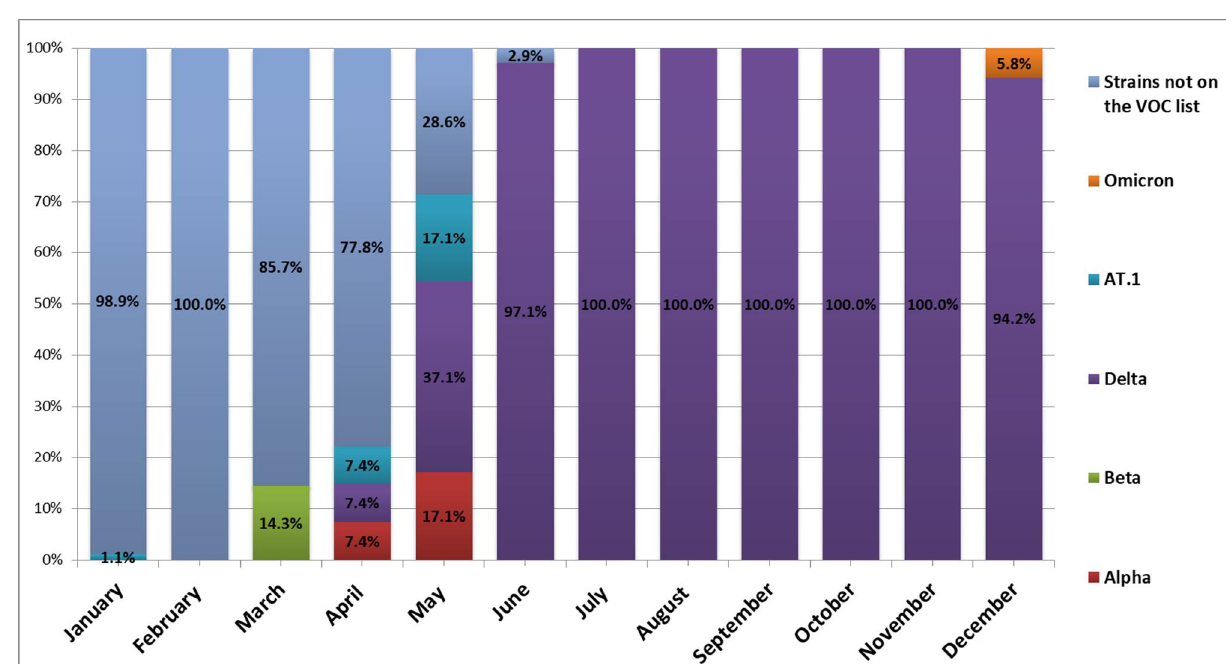
Figure 1. Monitoring dynamics of SARS-CoV-2 genetic variants circulating in St. Petersburg in 2021. Patient group 1 featured 116 men (50.2%) and 115 women (49.8%), aged 21 to 66 years. Patient group 2 featured 44 men (55.0%) and 36 women (45.0%), aged 22 to 53 years.